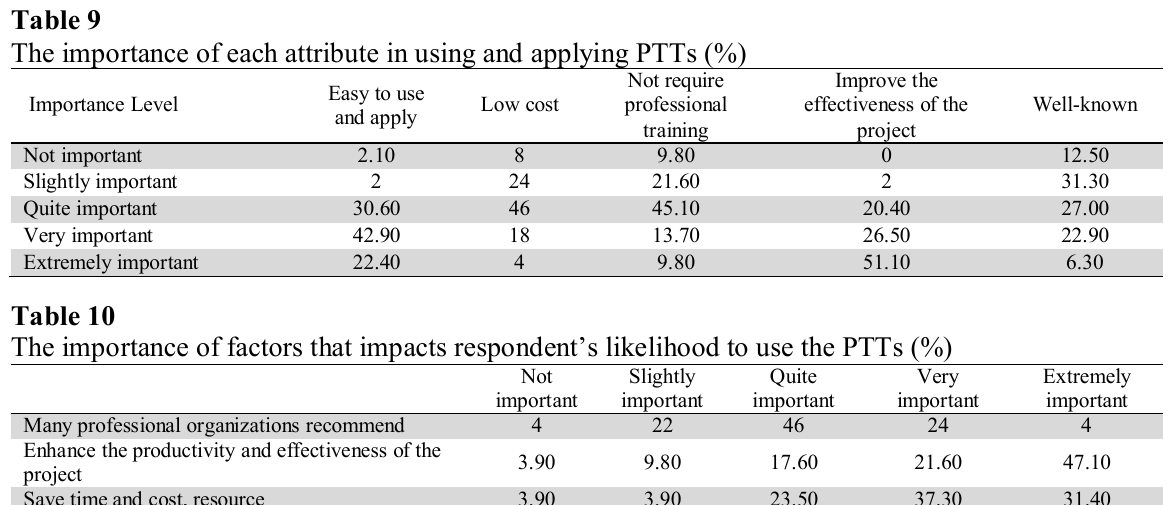
Easy to use and apply